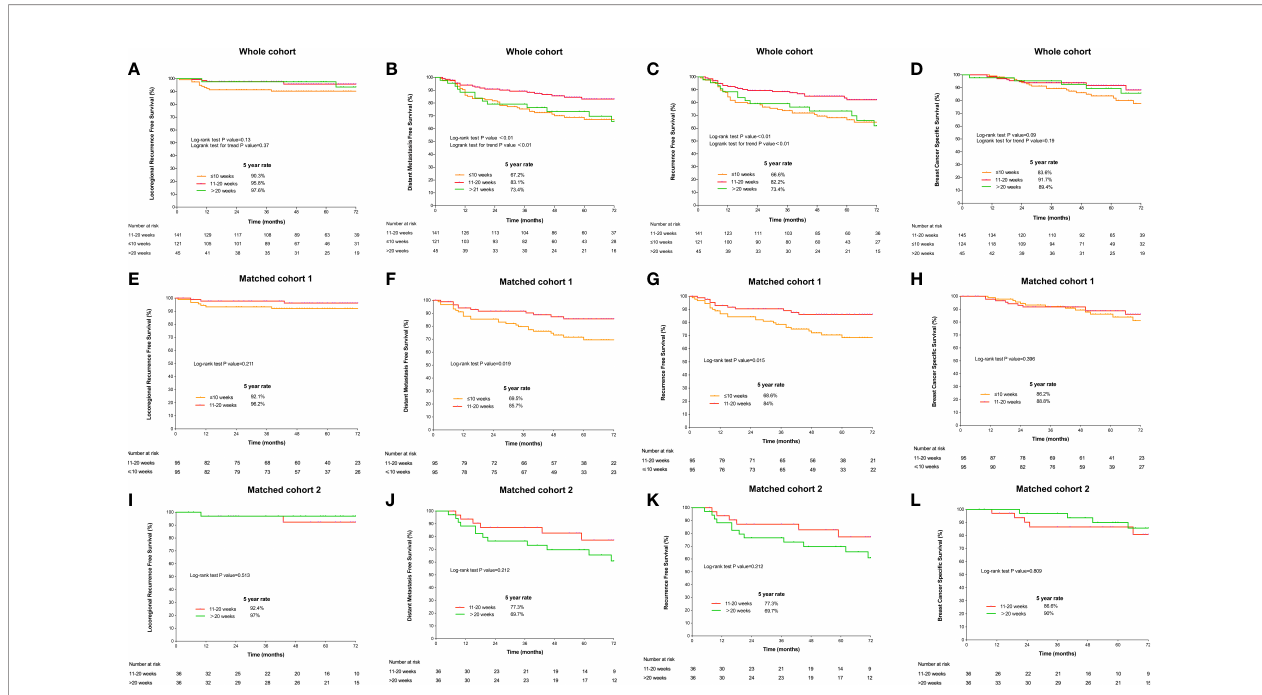
FIGURE 3 | Survival curves according to the time to initiation of adjuvant radiotherapy estimated by the Kaplan – Meier method and compared using the log-rank test in the whole cohort. (A) locoregional RFS; (B) distant metastasis-free survival; (C) recurrence-free survival; and (D) overall survival and in matched cohorts. Comparison of survival outcomes between the TTR groups of 11 – 20 weeks and >20 weeks: (E) locoregional RFS; (F) DMFS; (G) RFS; and (H) BCSS. Comparison of survival outcomes between the TTR groups of 11 – 20 weeks and ≤ 10 weeks: (I) locoregional recurrence-free survival; (J) DMFS; (K) RFS; and (L)